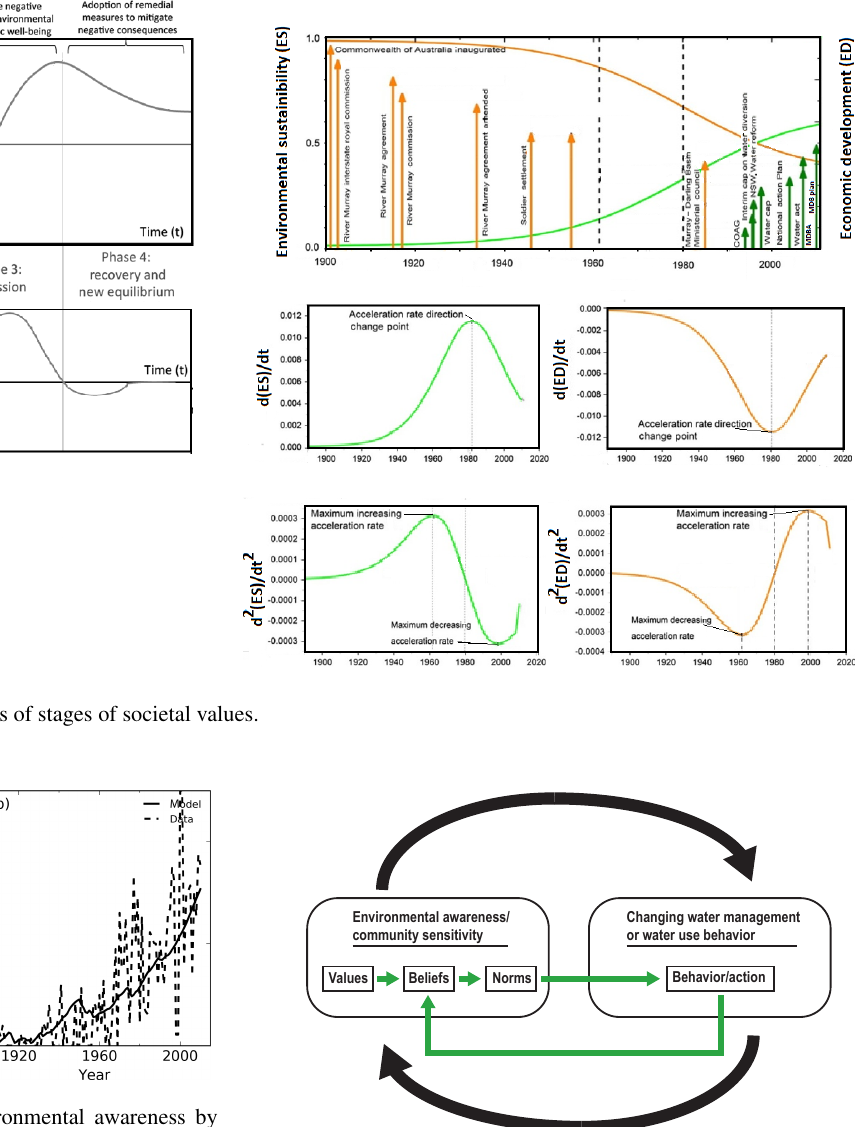
Figure 5. (a) Variation of modeled environmental awareness by van Emmerik et al. (2014) using a model calibrated with hydrolog- ical and population data; (b) variation of modeled environmental awareness using a model calibrated (solid line) with societal value data (data from Wei et al., 2017, dashed line) of water resources for environment stability.